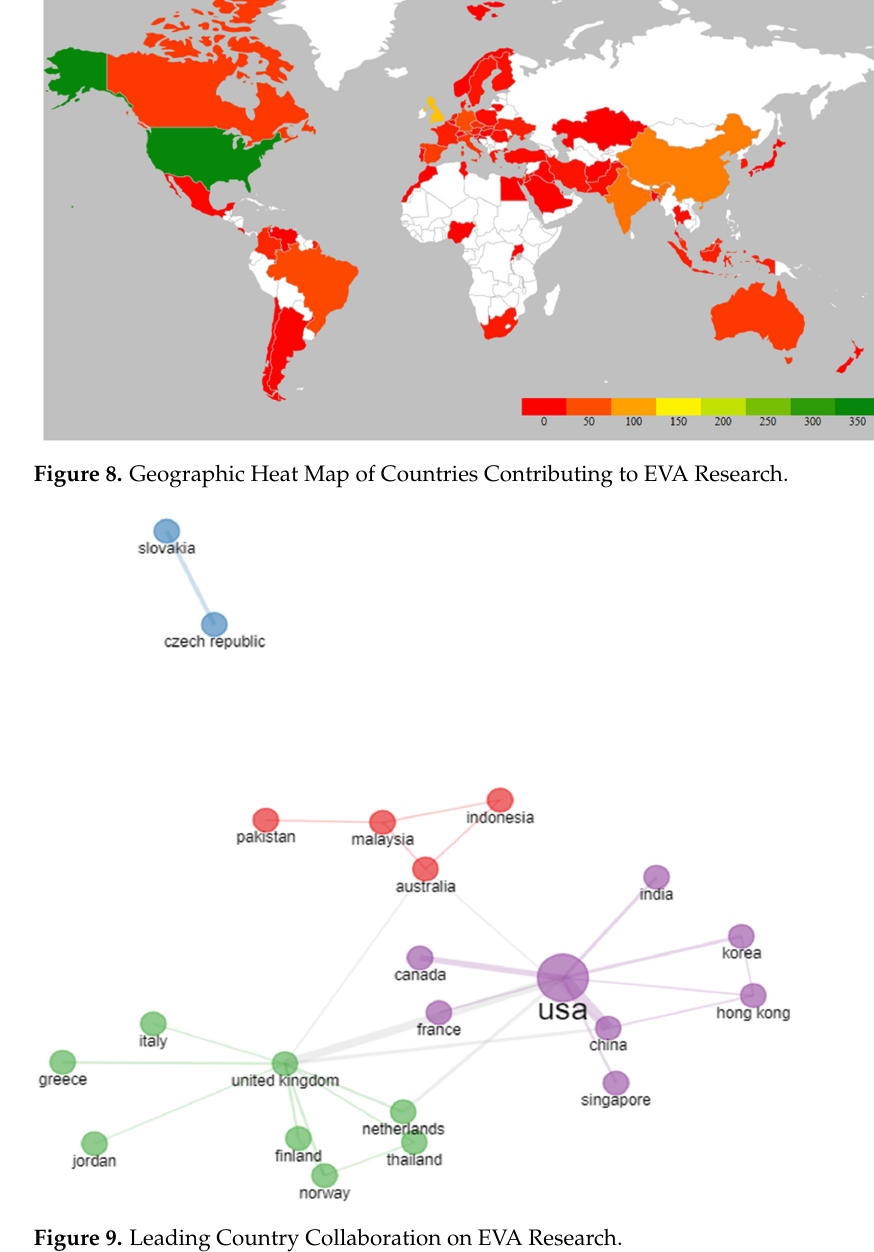
Figure 9. Leading Country Collaboration on EVA Research.